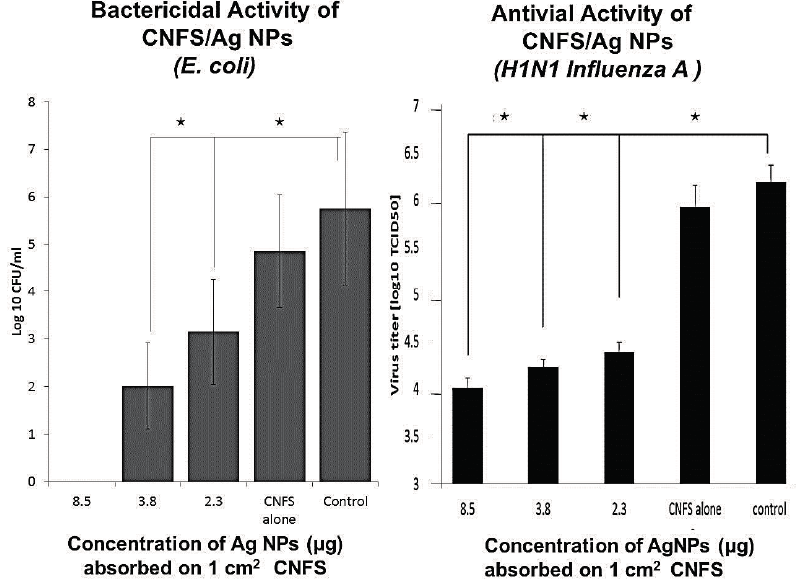
Figure 8. Bactericidal and antiviral activities of various concentrations of Ag NPs on CNFS. Asterisks ( * ) denote statistically significant differences ( p < 0.01) as determined using a two-sample t